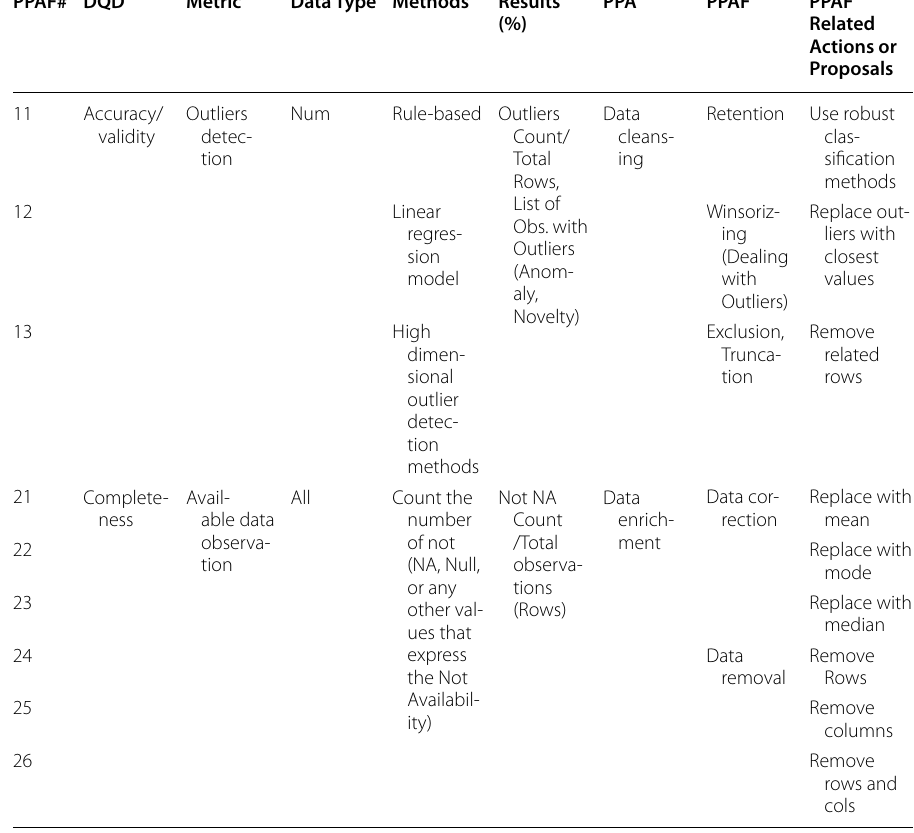
Table 5 DQD’s and their related pre-processing activities and functions PPAF#